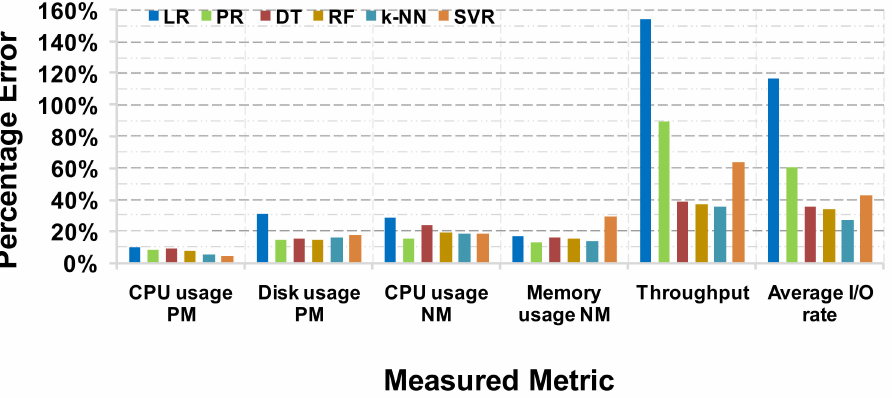
Figure 5. Comparison of six well-known ML algorithms applied to six system